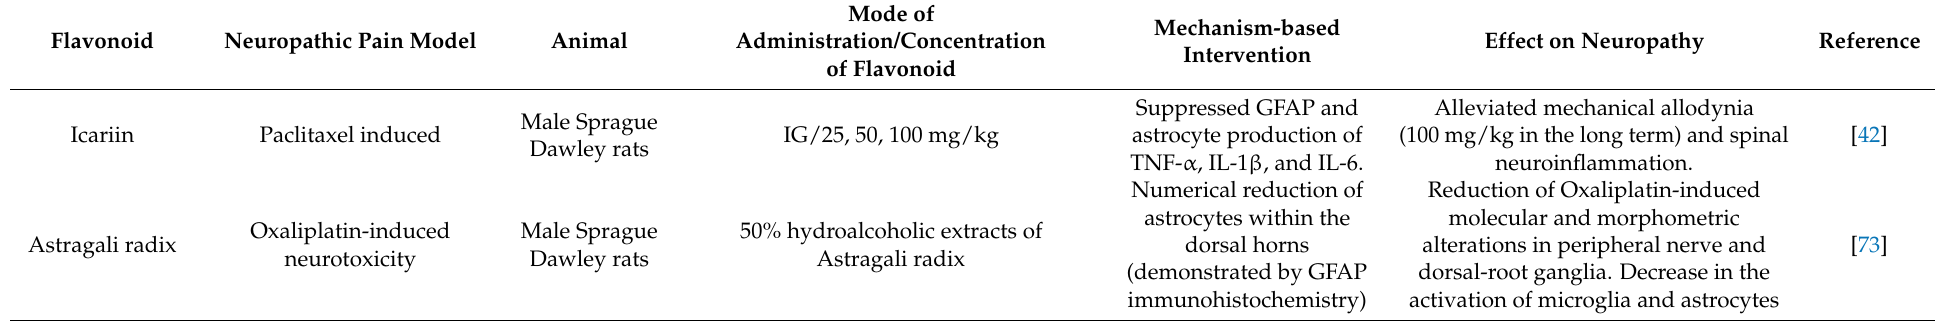
Table 8. Previous studies investigating the effects of flavonoids on CIPN